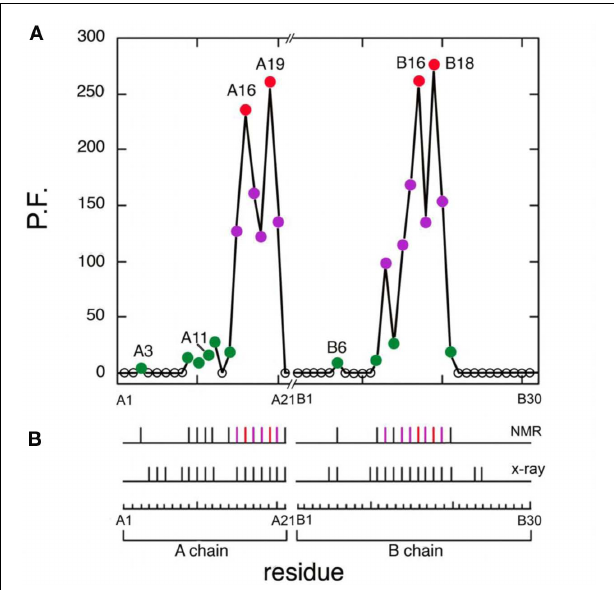
FIGURE 8 | Structural map of amide-proton exchange. (A) Sites of global exchange are shown in relation to a ribbon model of theT state: residues A16, A19, B16, and B18 cluster near cystine A20–B19 (box). (B) Corresponding ribbon model showing sites of subglobal exchange: residues A15, A17, A18, A20, B12, B14, B15, B17, and B19. (C) Sites of local exchange: residues A3, A9–A12, A14, B6, B11, B13, and B20. (D) Sites for which H N resonances were not observed in D 2 O, presumably due to rapid exchange (i.e., within 5min). Color bars at top in (A–C) indicate range of PFs shown relative to the maximum value set by global stability; normalized protection factors are given inTable S1 in Supplementary Material. Asterisk in (D) highlights lack of protection within the A1–A8 α -helix;Val A3 exhibits slight protection [arrowhead in (C)